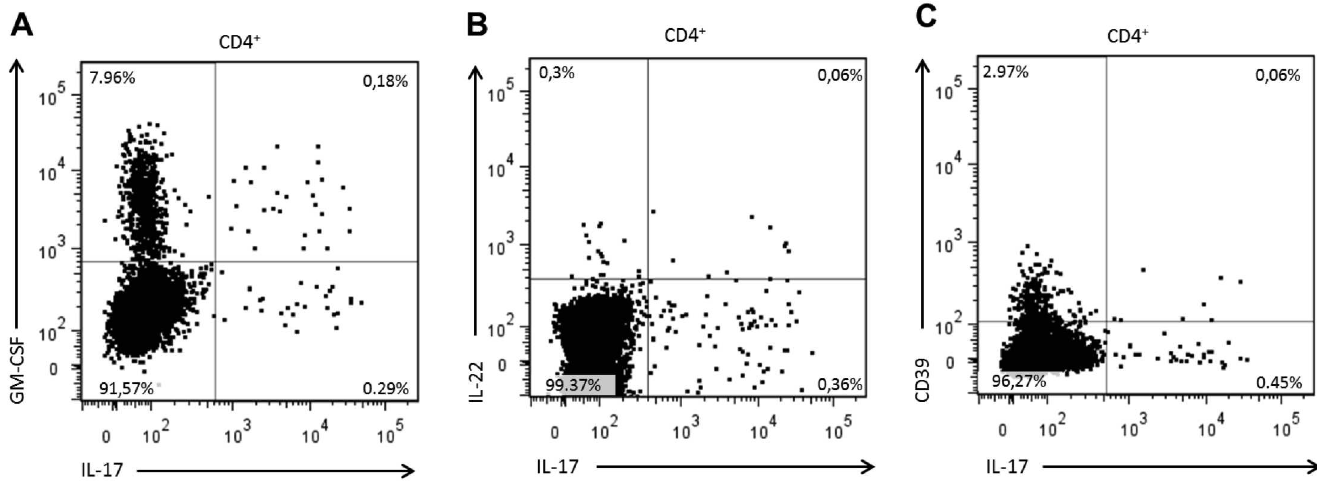
Fig 3. FACS analysis of GM-CSF, IL-22 and CD39 coexpressionwith IL-17 in CD4 + T cells. PBMCs were fixed and stained after 4h stimulationby PMA/ionomycin in the presence of a protein transport inhibitor.CD4 + cells were gated among the CD3 + population.Representative dot plots of (A) GM-CSF, (B) IL-22 and (C) CD39 costainingwith IL-17. Numbers in each quadrant represent the averagepercentageof positive CD4 + T cells in relapsing MS patients.